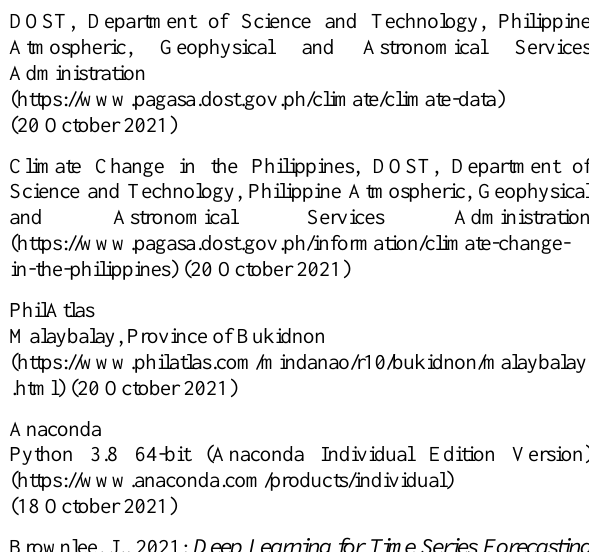
Figure 12. Density Plot DOST-PAGASA